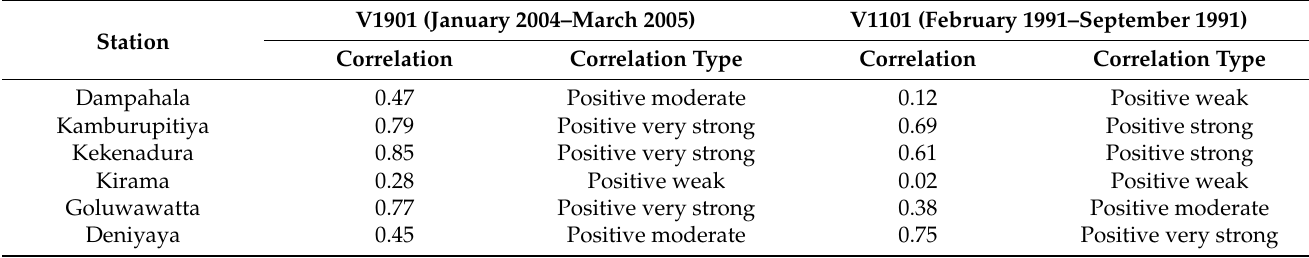
Table 2. Results of correlation check—observed data vs. APHRODITE data.